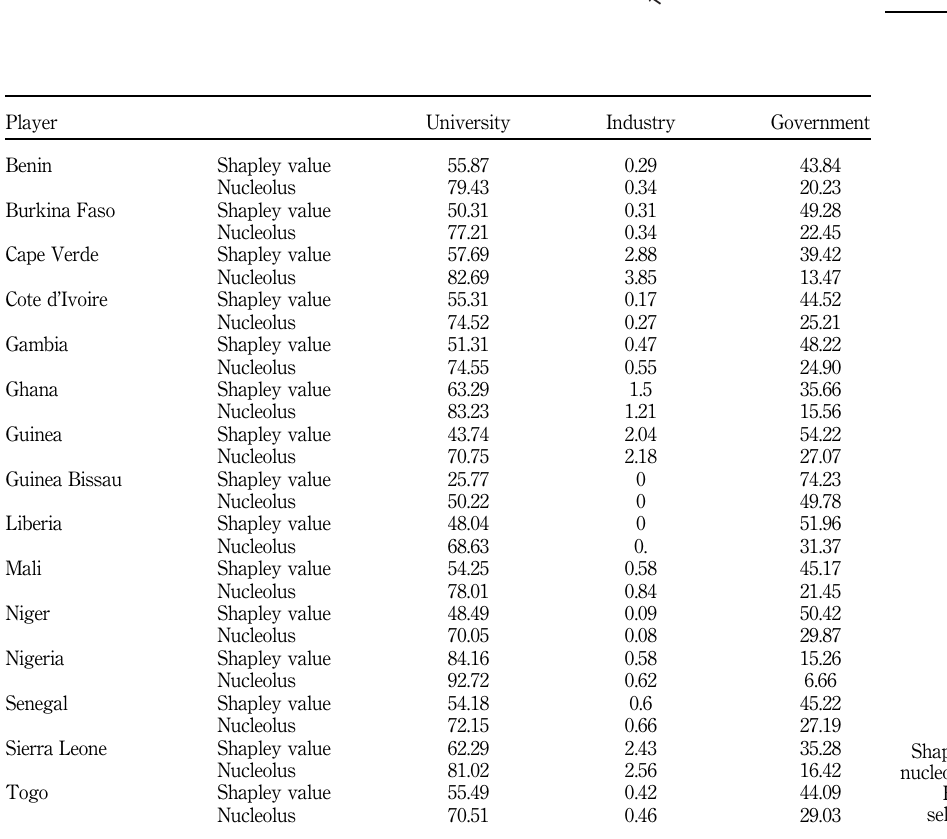
Figure 8. Core of Cape Verde